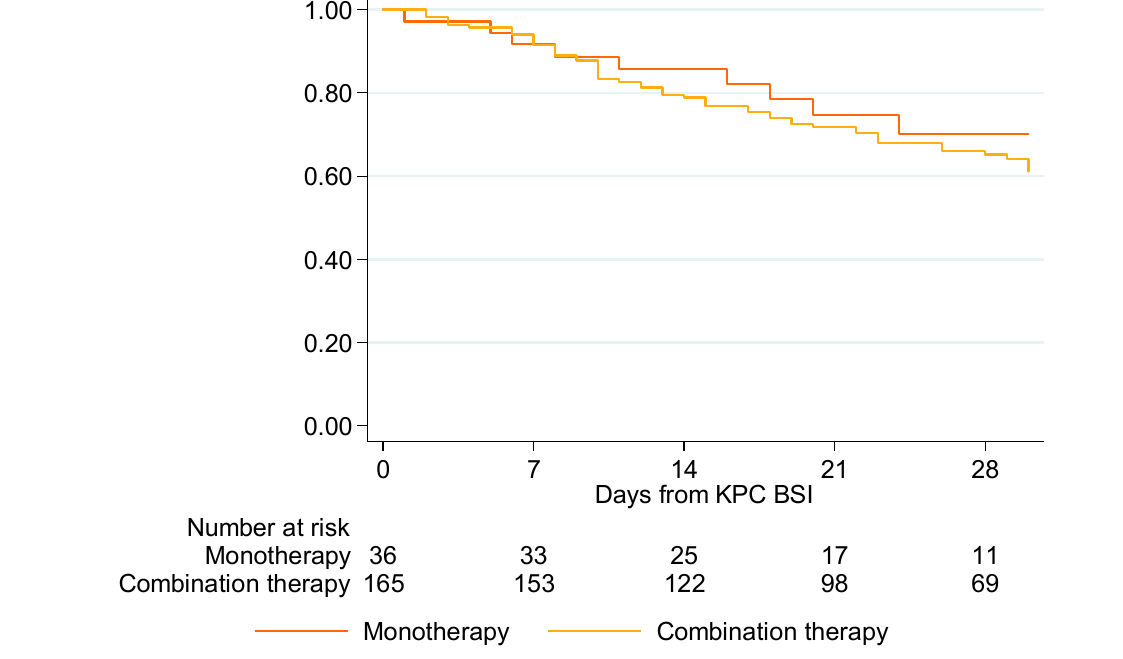
Figure 1. Kaplan–Meier estimate of patient survival for patients receiving appropriate empirical monotherapy and appropriate empirical combination therapy ( n = 201).